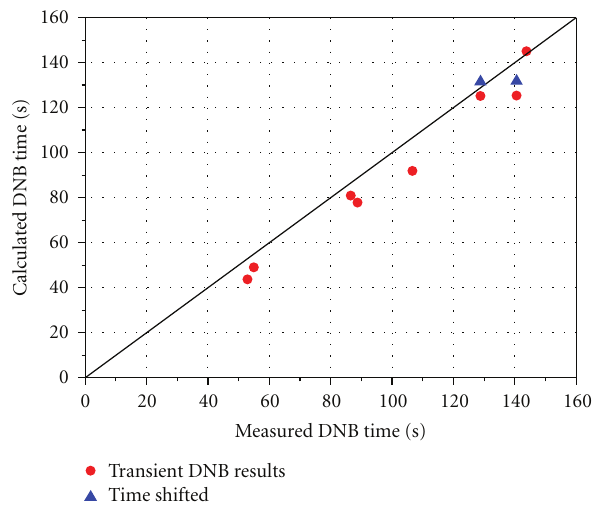
Figure 21: Results of transient DNB